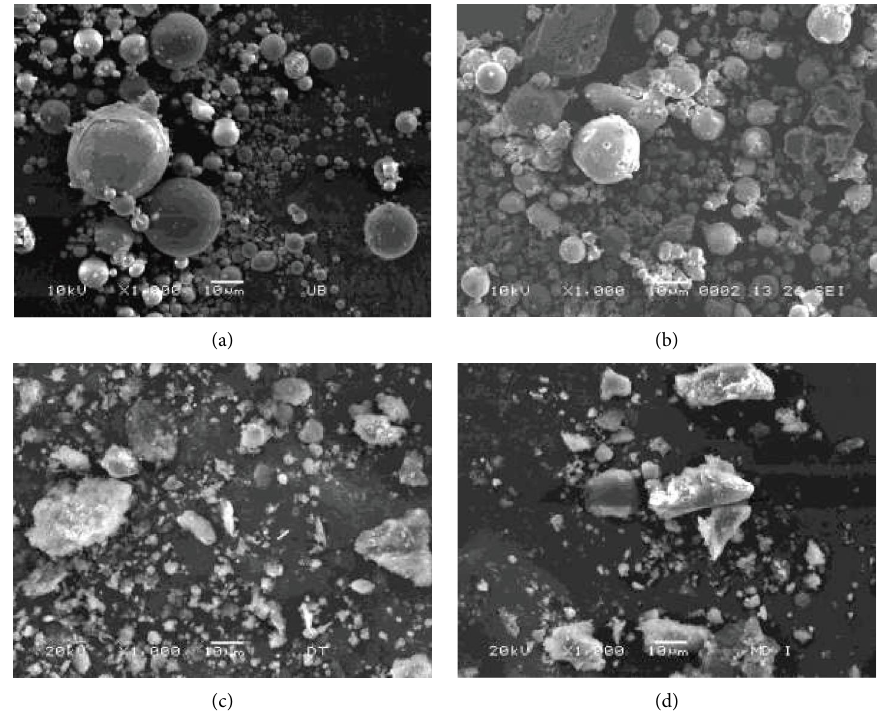
Figure 1: Scanning electron microscopy images of fy ash: (a) Uong Bi PCC, (b) Ninh Binh PCC, (c) Dong Trieu FBC, and (b) Mong Duong I